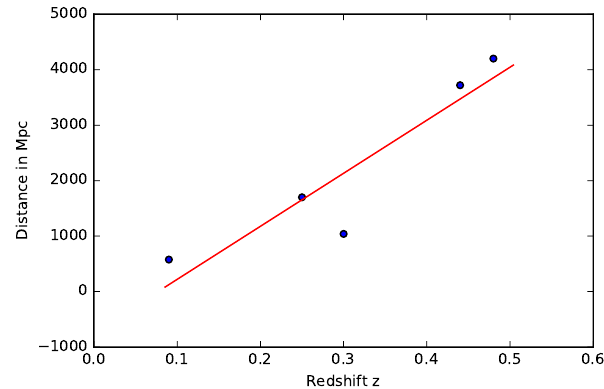
Fig. 91.— Hubble diagram, with the best-fit line